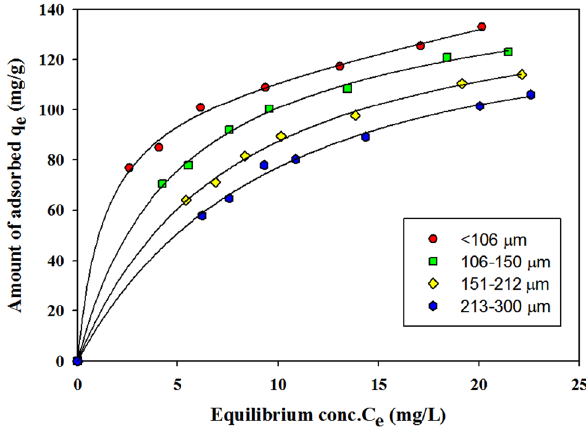
Fig. 5 Comparison of adsorption isotherms of methylene blue on coconut coir dust with different particle